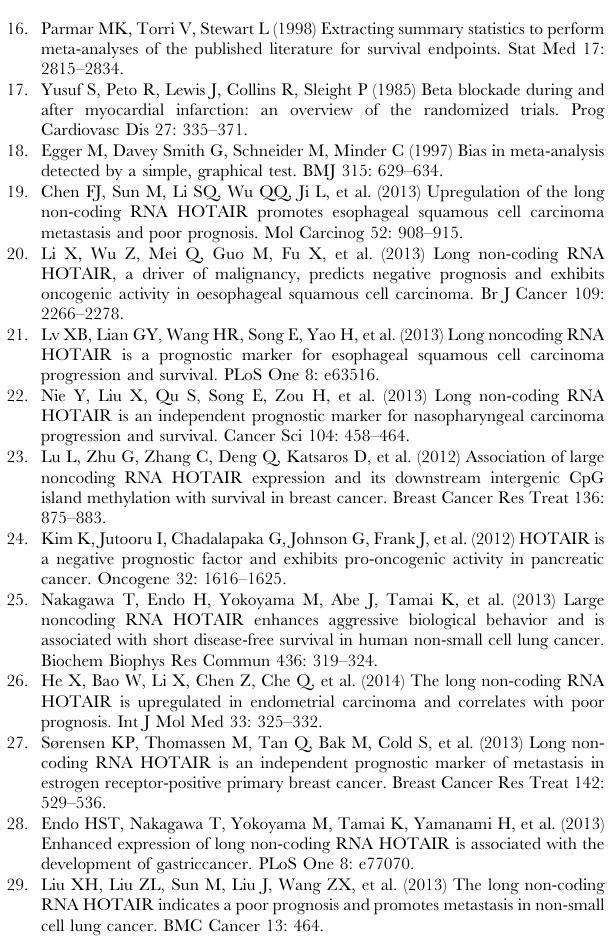
Figure S1 Sensitivity analysis of the association be- tween HOTAIR expression and OS/RFS/MFS of cancer. (A) Sensitivity analysis of the pooled HRs of OS of different types of cancer with increased HOTAIR expression; (B) Sensitivity analysis of the independent role of HOTAIR in OS/recurrence/ metastasis of different types of cancer; (C) Sensitivity analysis of the pooled HRs of RFS of cancer with increased HOTAIR expression; (D) Sensitivity analysis of the pooled HRs of MFS of cancer with increased HOTAIR expression. (TIF)